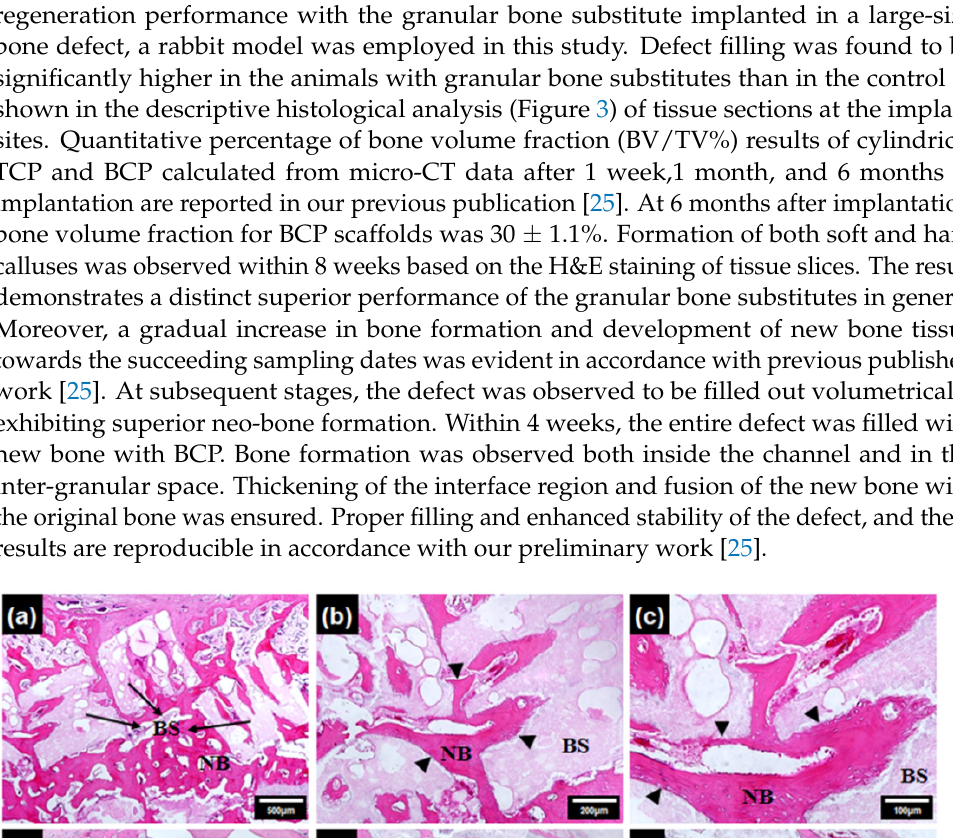
Figure 2. Physical and mechanical characterization of the granular bone substitute ( a ) pore size, ( b ) compressive strength. ** ≤ 0.01, *** ≤ 0.001